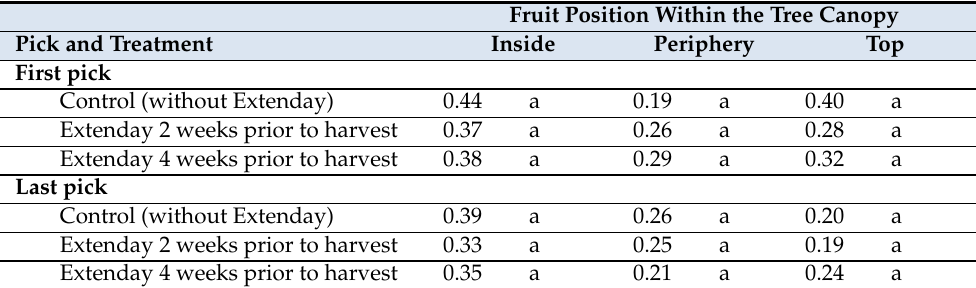
Table 4. Quality parameter (Streif index) of cv. Pacific Rose apple at each pick dependent on fruit position within the tree canopy. Fruit Position Within the Tree Canopy Pick and Treatment Inside